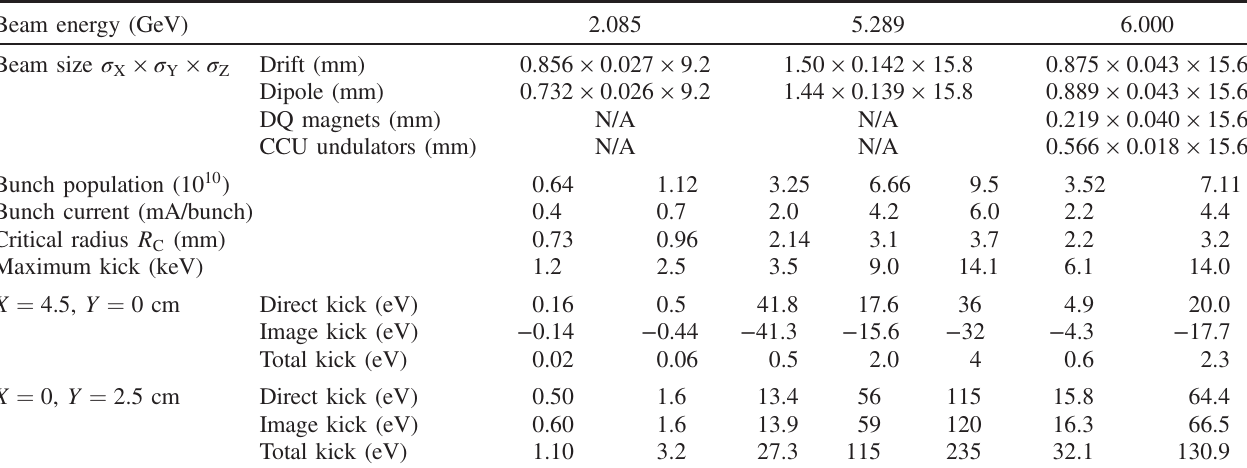
TABLE II. Parameters for the acceleration provided by a positron bunch to a cloud electron located at the vacuum chamber wall on the X or Y axes. These examples correspond to the C ESR TA measurements of betatron tune shifts as well as for the predictions for the 6.0 GeVupgrade of CESR [8,36]. Kick values for the case of the field-free regions of the ring are shown. The total kick values are given as the kinetic energy of the electron following acceleration by the positron bunch in the impulse approximation. The direct and image kick values are signed according to whether they add or subtract from the total kick. The beam sizes shown are averages over the field- free, dipole, combined-function (DQ) magnet and compact undulator (CCU) regions of the ring. Beam energy